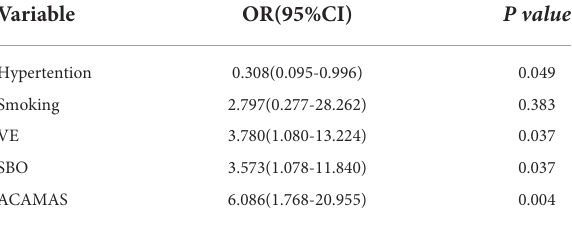
TABLE 3 Multivariate analysis of risk factors for intraprocedural rupture.